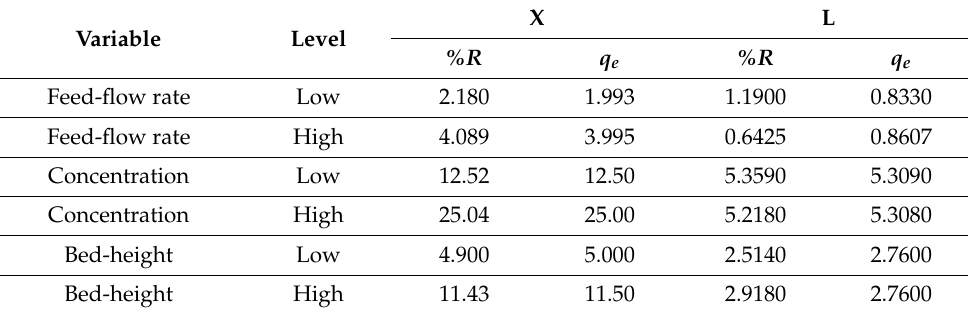
Table 5. Parameters of the ANFIS model for the %R and q e fitting. Variable